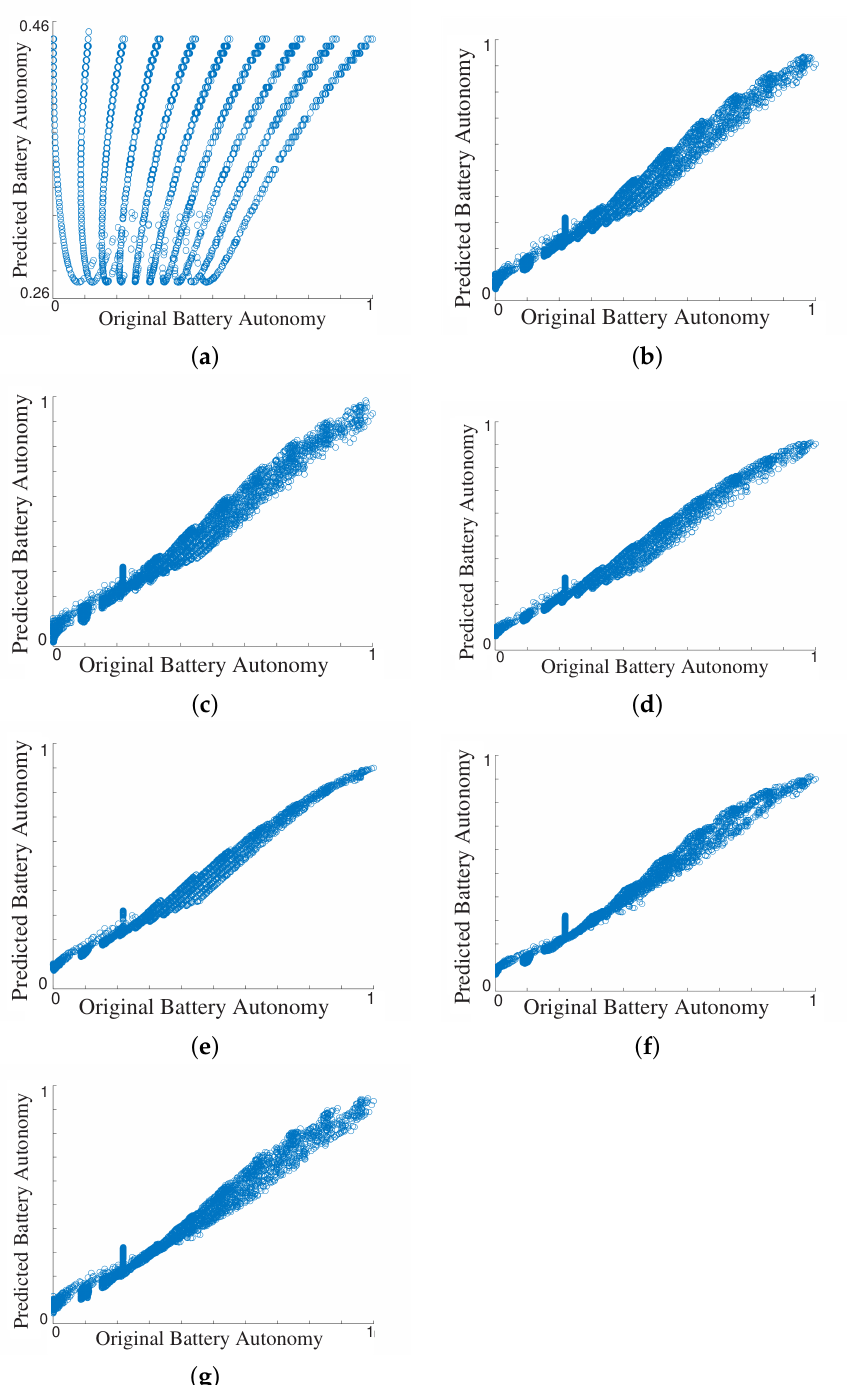
Figure 5. Scatter plots for the original vs. predicted battery autonomy scores ( a ) all features; ( b ) evolutionary search; ( c ) genetic search; ( d ) harmony search; ( e ) linear forward seection; ( f ) particle swarm optimization; ( g ) ranker